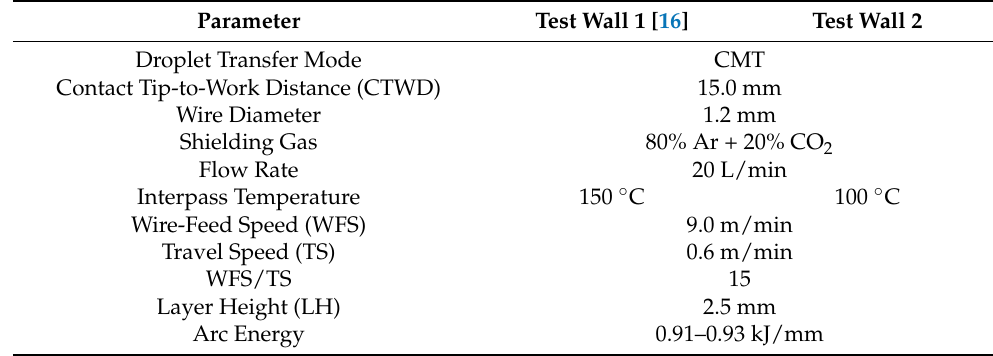
Table 2. Summary of WAAM fabrication parameters.